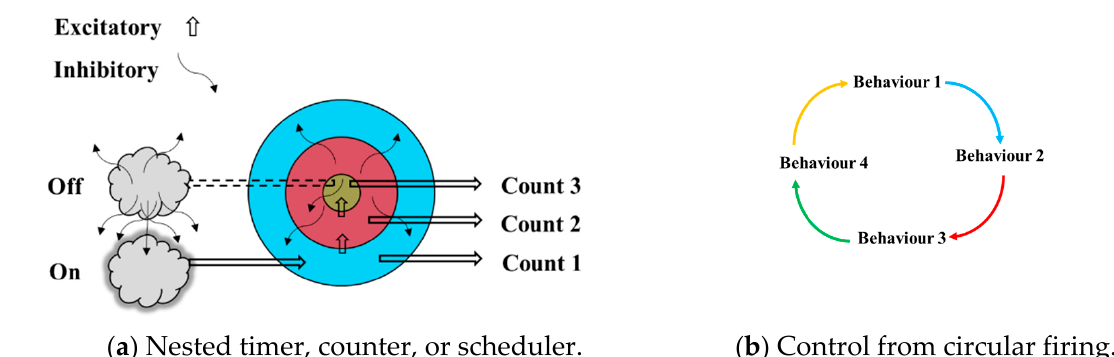
Figure 1. Nested Scheduling [2], or circular scheduling.